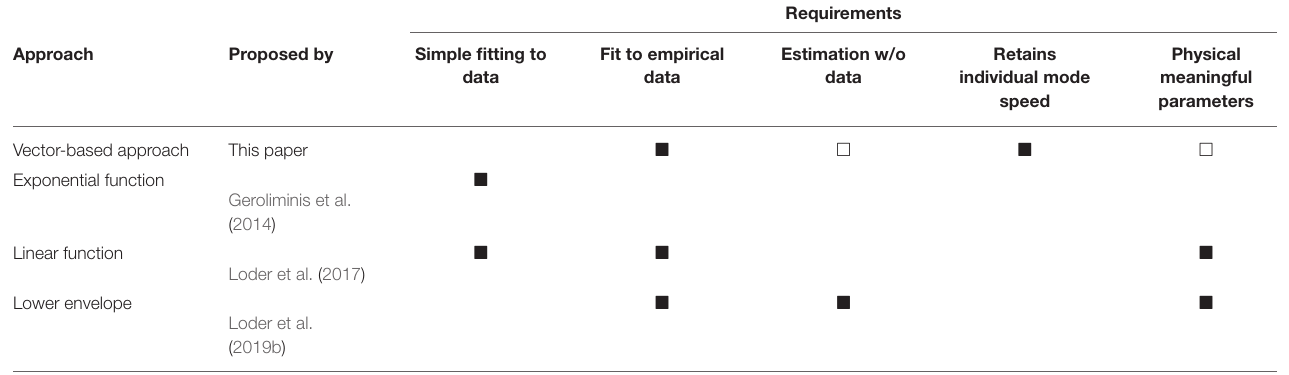
TABLE 1 | Comparison of 3D-MFD estimation methods.